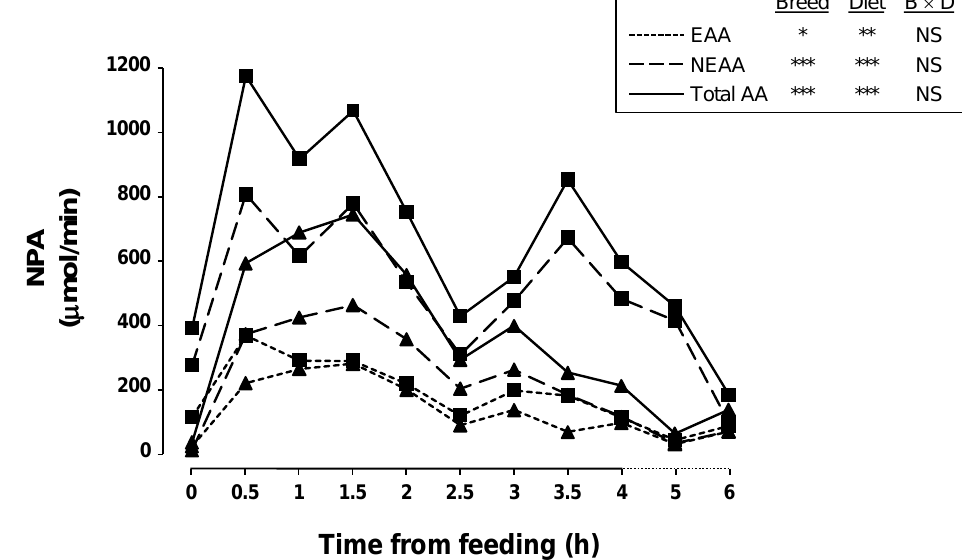
Figure 1. NPA of EAA, NEAA and total AA along a 6 h sampling in Iberian ( (cid:78) ) and Landrace ( (cid:4) ) pigs ( n = 6/breed (B)) fed two diets (D) of different protein content. * p < 0.05, ** p < 0.01, *** p < 0.001, NS = not significant ( p > 0.05).